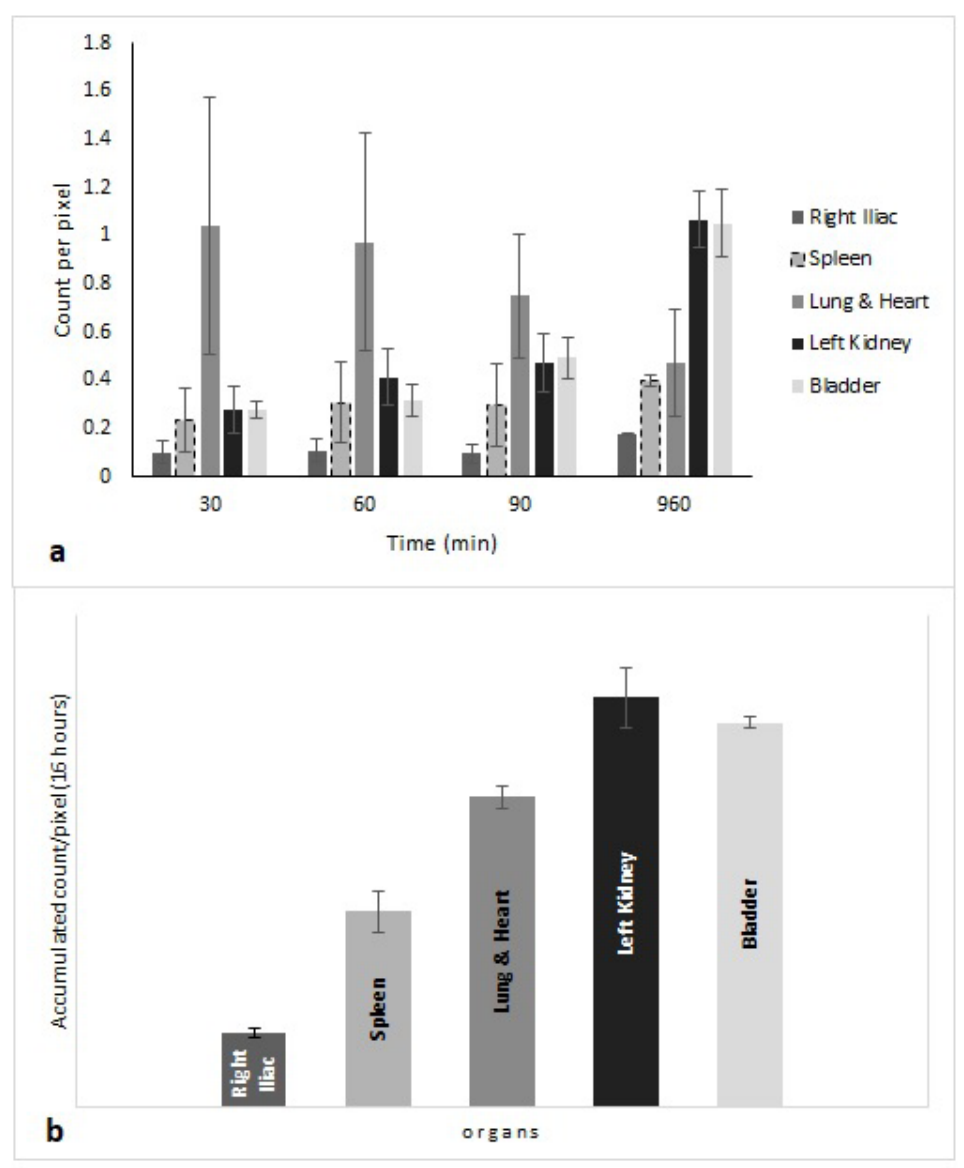
FIGURE 3 - The activity of target organs at different intervals (30, 60, and 90 minutes and 16 hours) (a) and the accumulated activity over 16 hours after injection